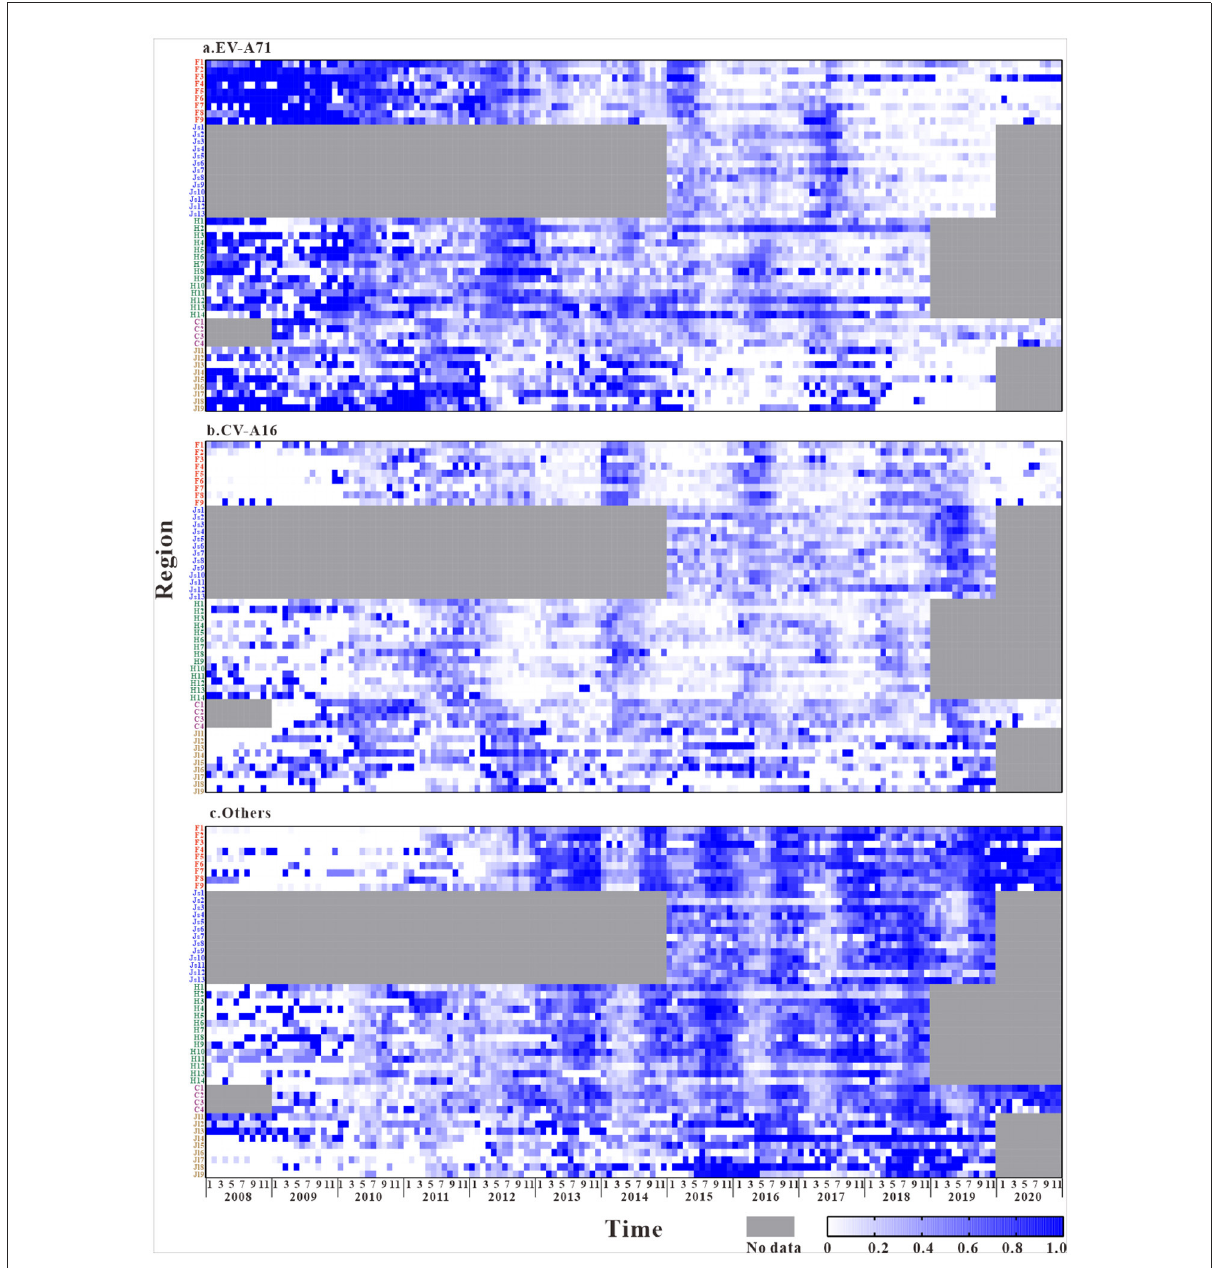
FIGURE2 The composition ratio characteristics of different pathogens in the five regions (The composition ratio of EV-A71 = Number of EV-A71 tests per month / Total number of laboratory tests per month, The composition ratio of CV-A16 = Number of CV-A16 tests per month / Total number of laboratory tests per month, The composition ratio of Others = Number of Others tests per month / Total number of laboratory tests per month. F1, Fuzhou City; F2, Xiamen City; F3, Putian City; F4, Sanming City; F5, Quanzhou City; F6, Zhangzhou City; F7, Nanping City; F8, Longyan